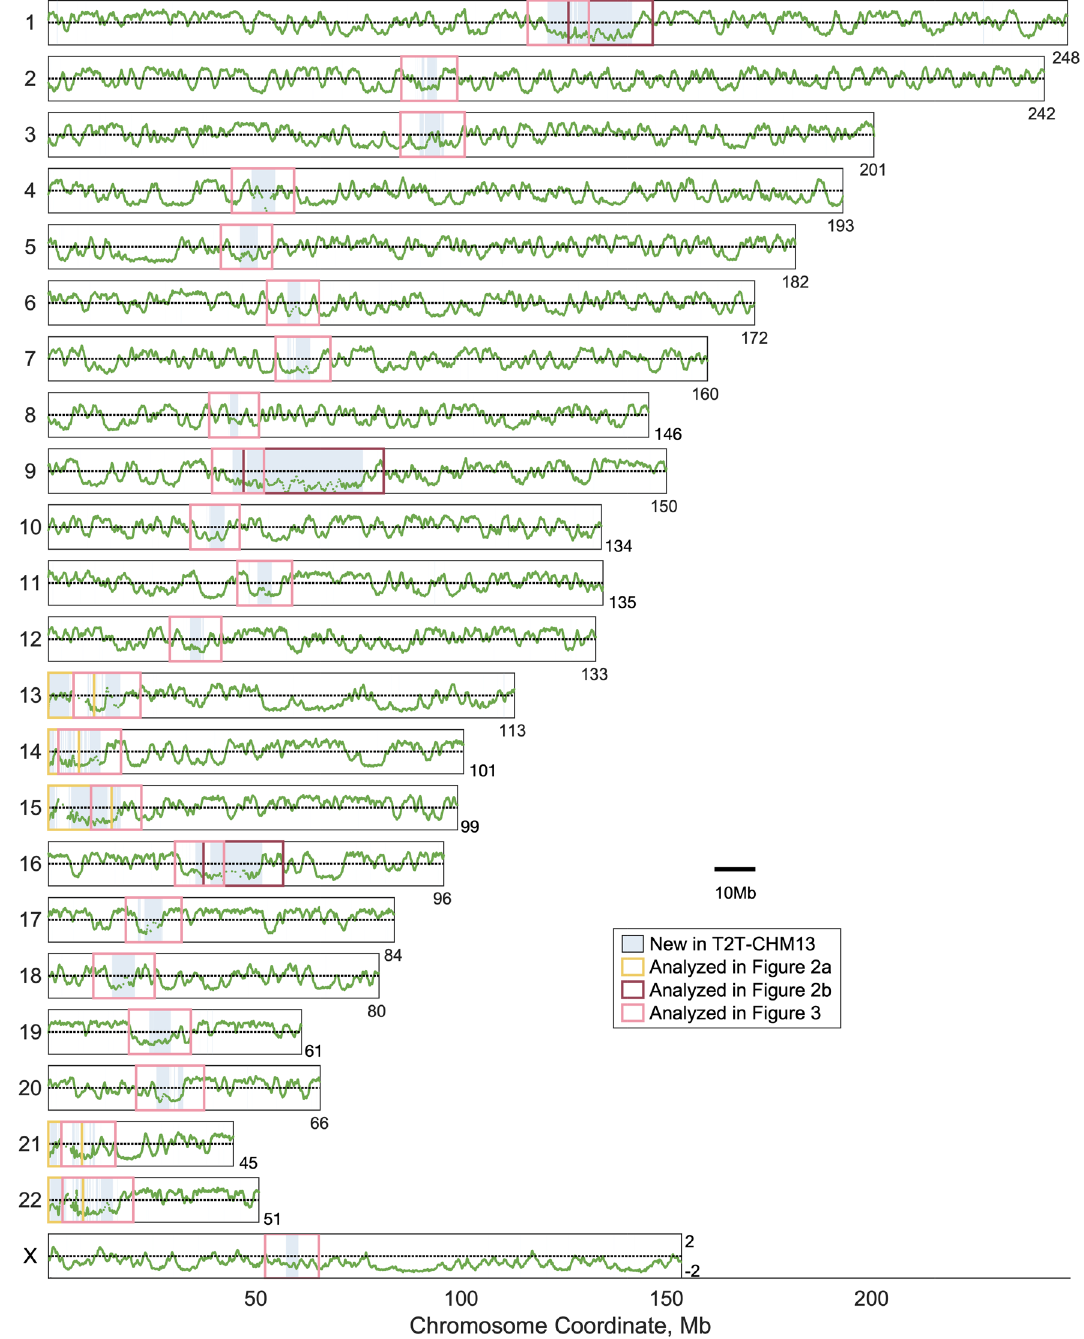
Figure 1. Telomere-to-telomere replication timing profiles for all autosomes and chromosome X. 1-kb windows in T2T-CHM13 that cannot be lifted over to hg38 (5.86%) are indicated with blue shading. Replication timing values are scaled to an autosome-wide mean of zero (black line). All chromosomes are shown on the same scale. The replication-timing profile for GM12878 is